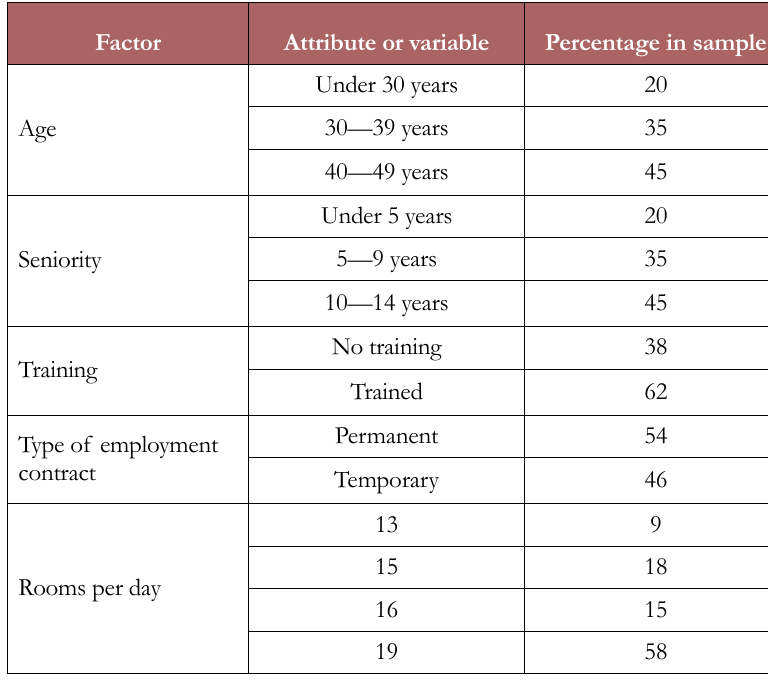
Table 3. Observations (%) by cleaning staff characteristics (n =